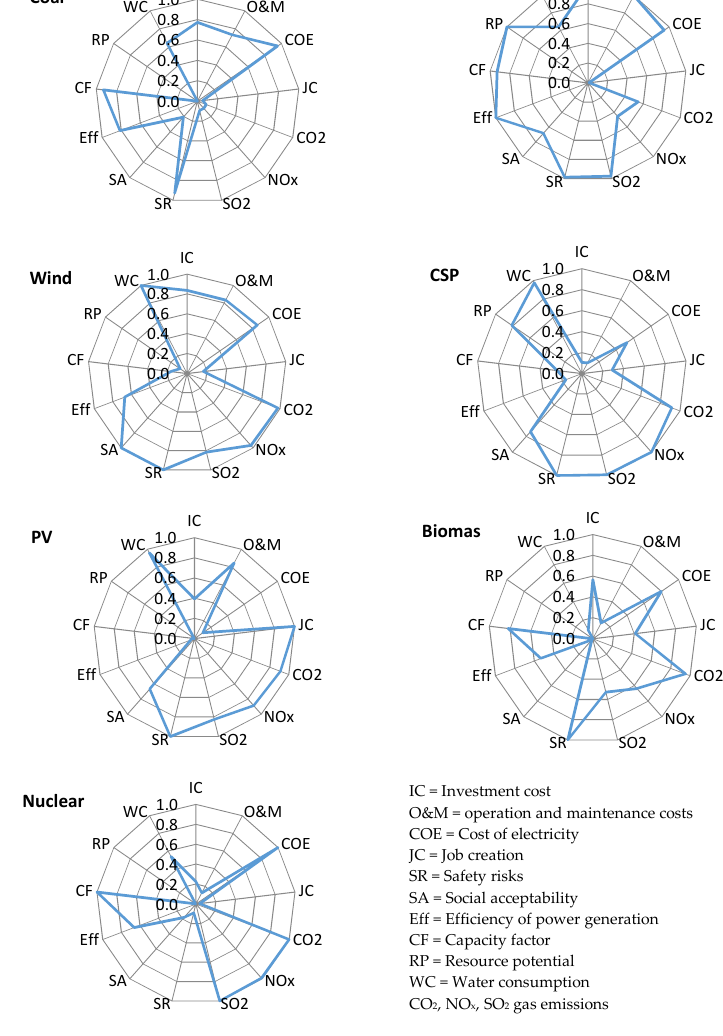
Figure 7. Normalized multi-criteria evaluation of energy systems.